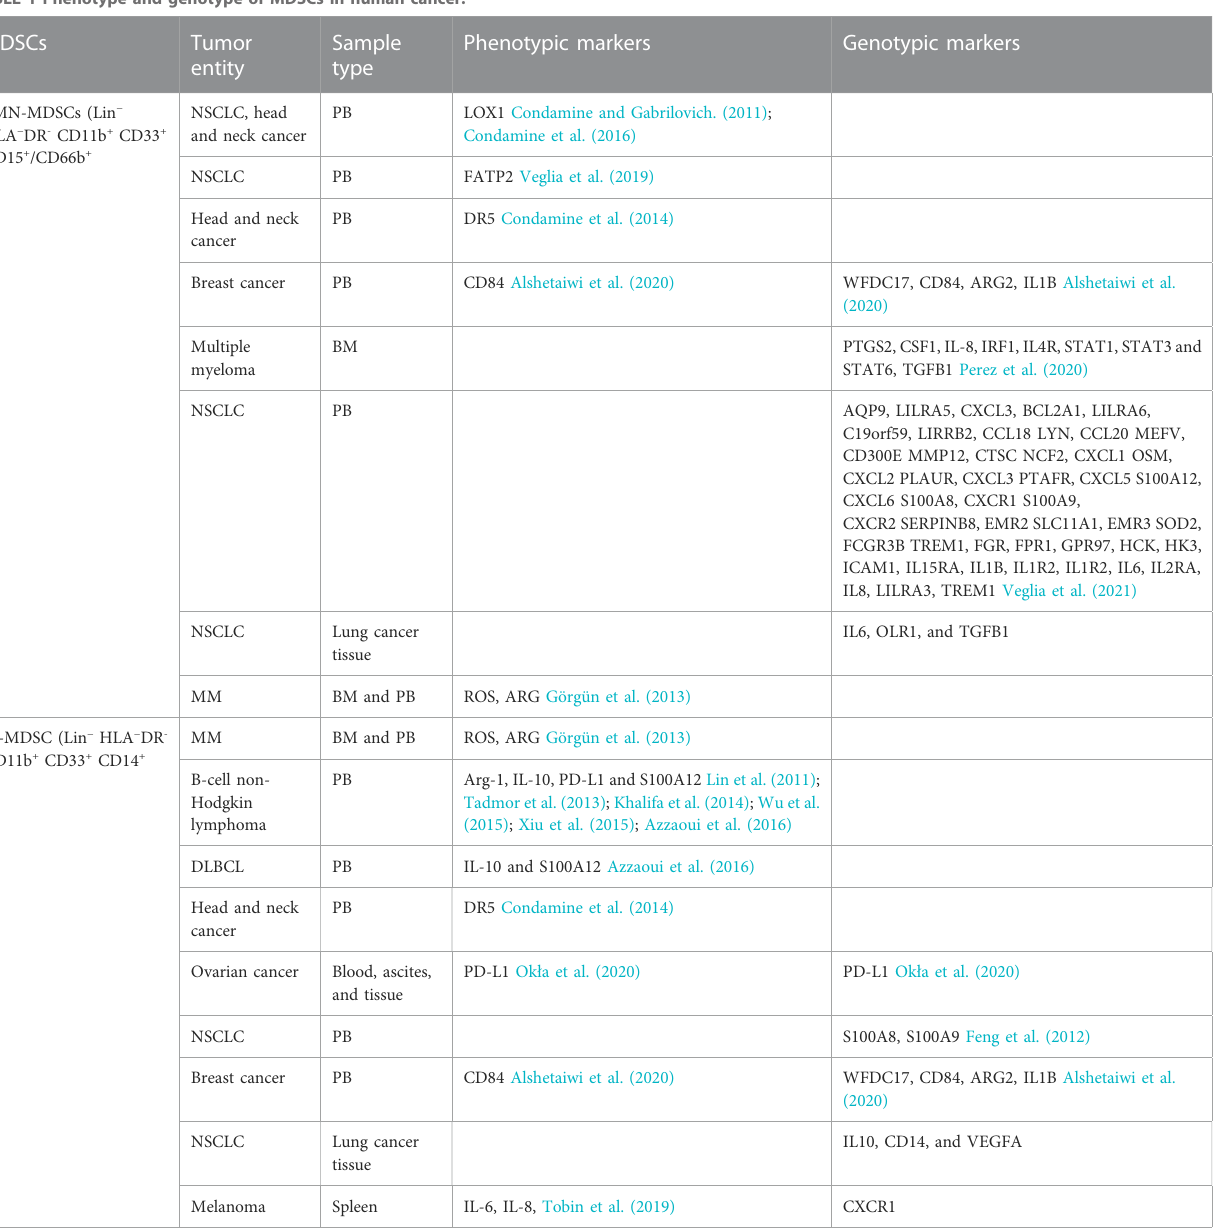
TABLE 1 Phenotype and genotype of MDSCs in human